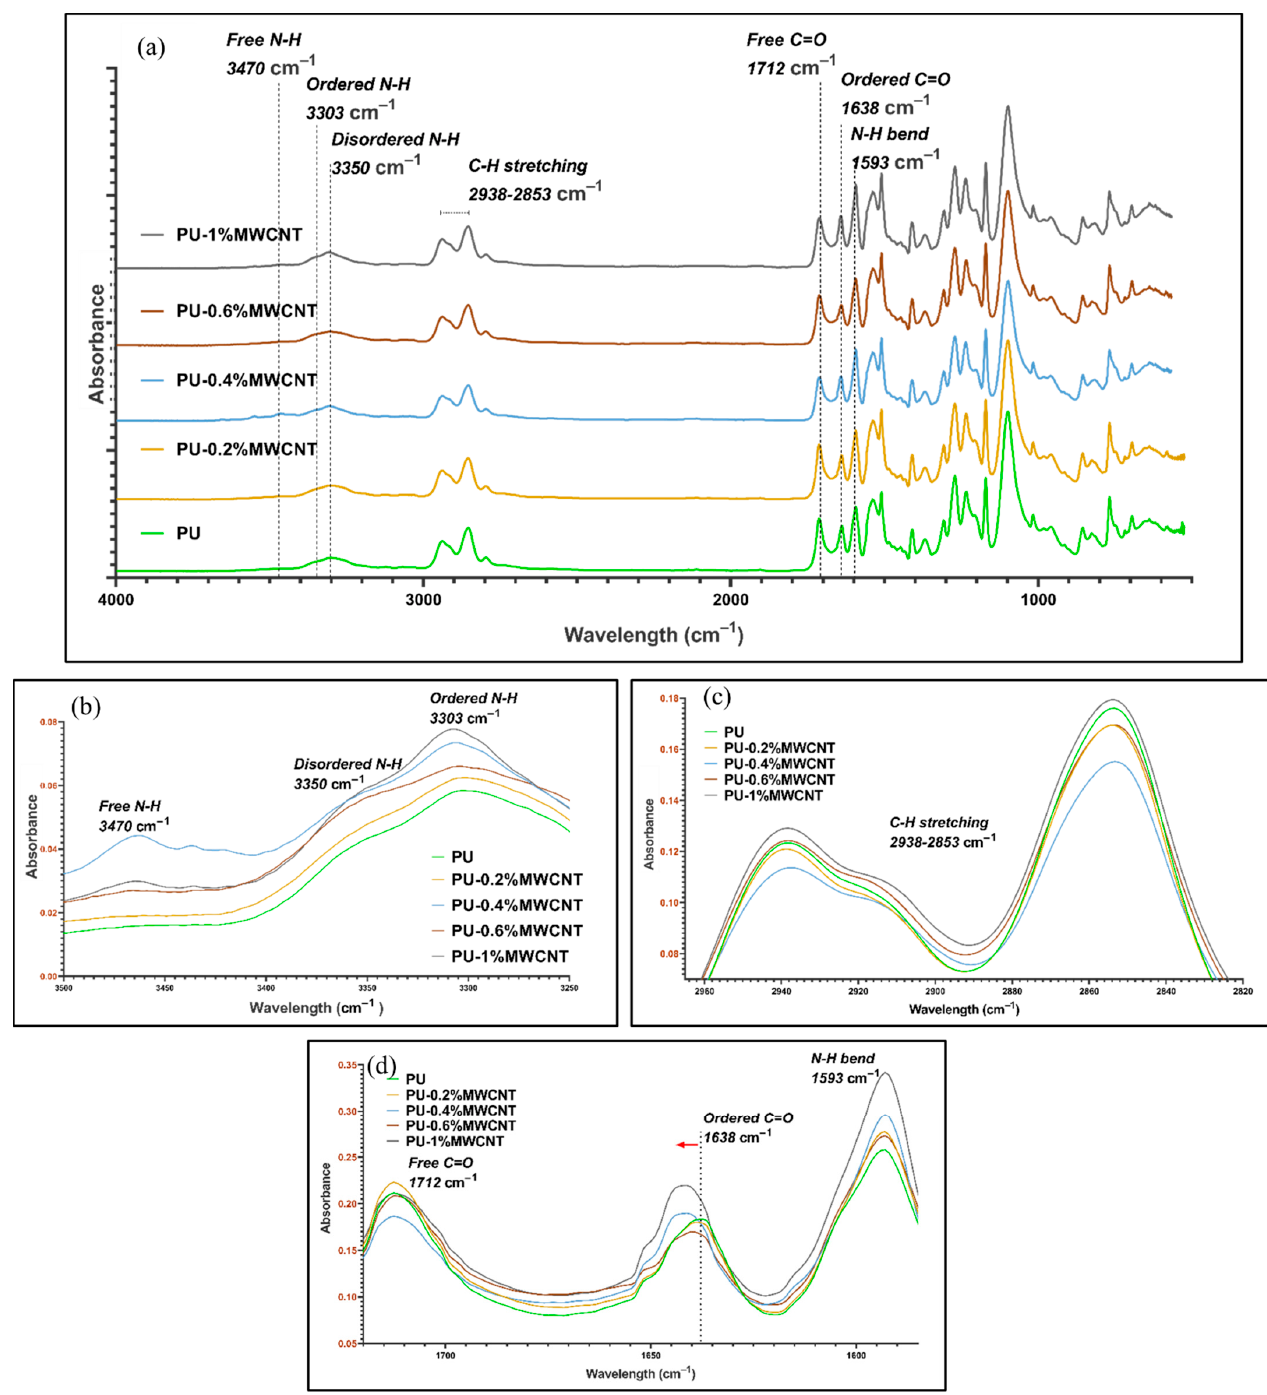
Figure 7. FTIR spectra of ( a ) PU and MWCNT nanocomposite films with loadings of 0.2%, 0.4%, 0.6%, and 1%, ( b ) N-H bands, ( c ) C-H bands, and ( d ) carbonyl bands.